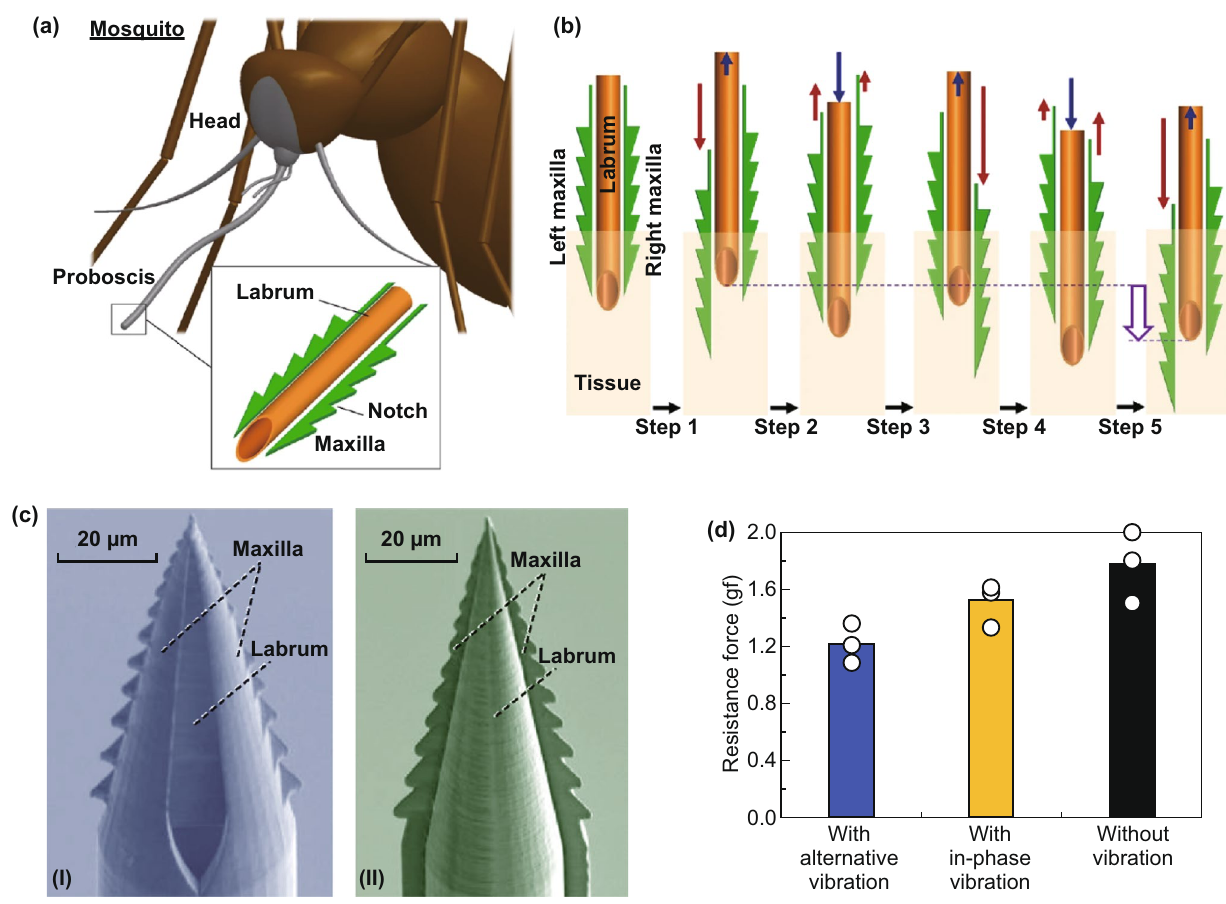
Fig. 18 a Mosquito proboscis has a hollow labrum and two harpoon-shaped notched maxillae. b The incremental motion during the proboscis insertion reduces insertion force and surrounding tissue deformation. Reprinted from Ref. [208] with permission from Nature. c Magnified SEM images of microneedles made of IP-Dip polymer: (I) front view and (II) back view. d Resistance force under each vibration condition when the displacement is 0.8 mm. Circle indicates each measured value, and height of bar indicates the averaged value. Reprinted from Ref. [207] with permission from